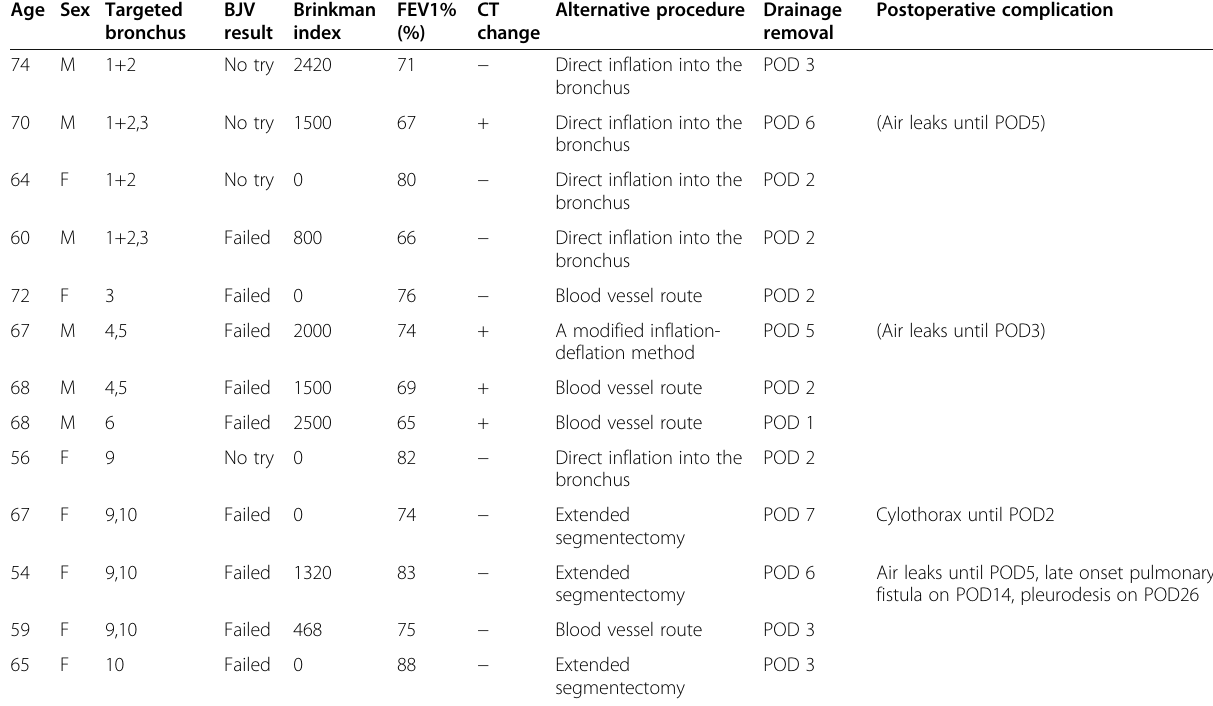
Table 4 Unsuccessful cases of thoracoscopic pulmonary segmentectomies with bronchoscopic jet ventilation Age Sex Targeted